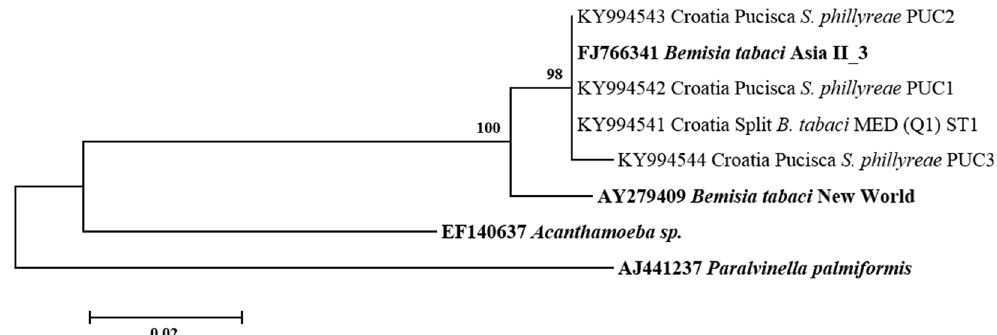
Figure 7. Molecular phylogenetic placements of Cardinium from whitefly species. The tree was constructed via Bayesian inference (BI) using an HKY+I substitution model. Sequences from GenBank are indicated in bold, while those obtained in this study are rearranged based on geographical origin and associated whitefly hosts, B. tabaci and S. phillyreae .